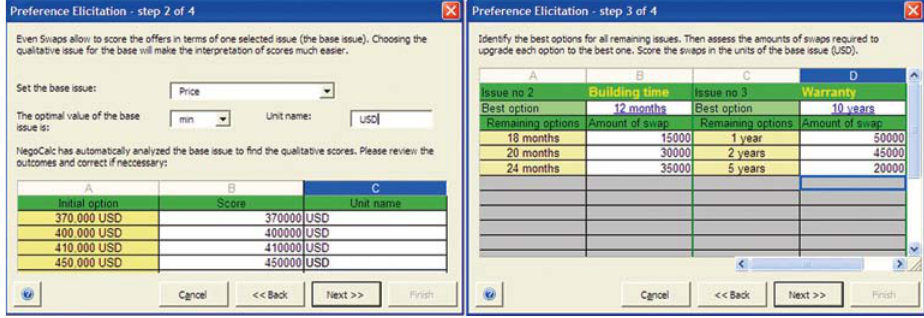
Fig. 3. Building a scoring system of negotiation offers in